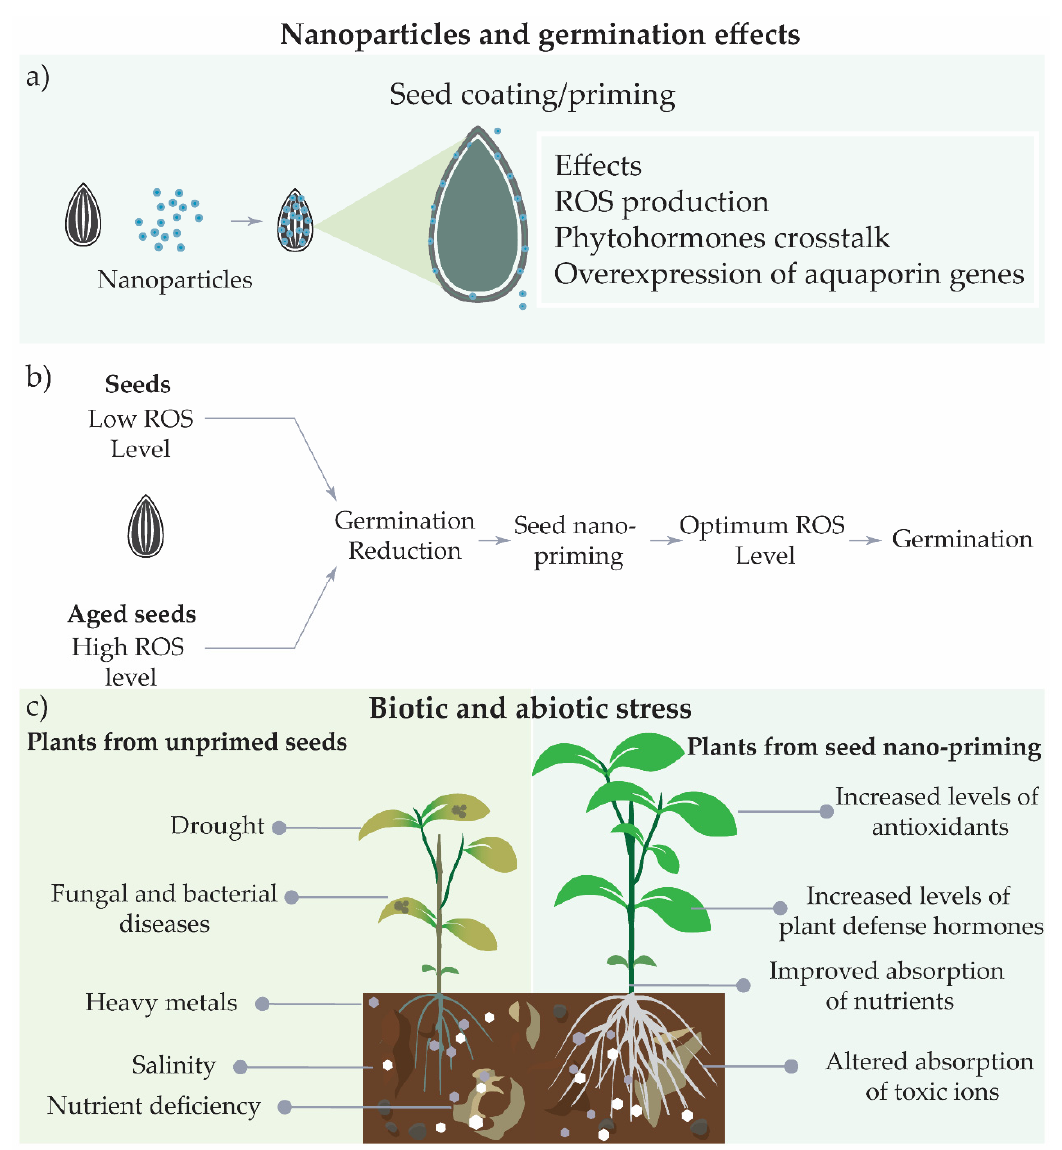
Figure 4. Effects of seed nano-priming on seeds and plants under abiotic and biotic stresses. ( a ) Effects of seed nano- priming during the germination, ( b ) effects of seed nano-priming on ROS levels, and ( c ) potential effects under biotic and abiotic